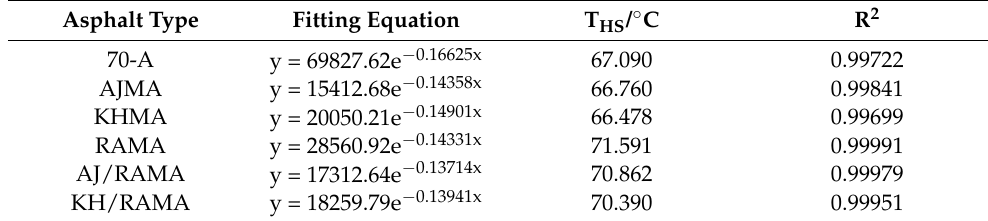
Table 4. The relationship curve and critical temperature T HS .